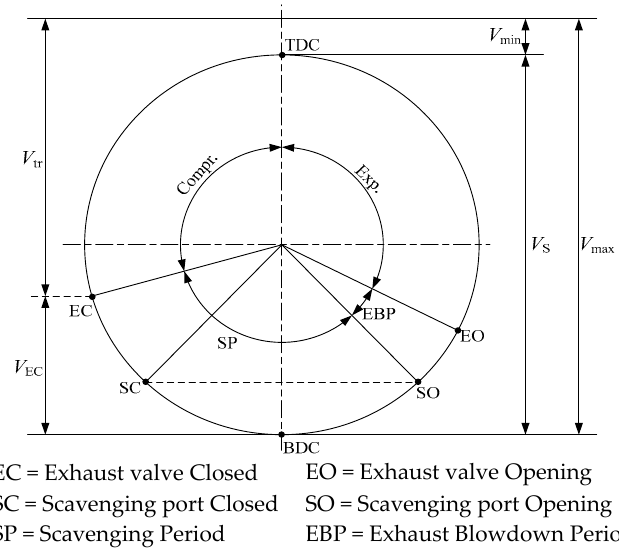
Figure 4. The timing diagram for a two-stroke diesel